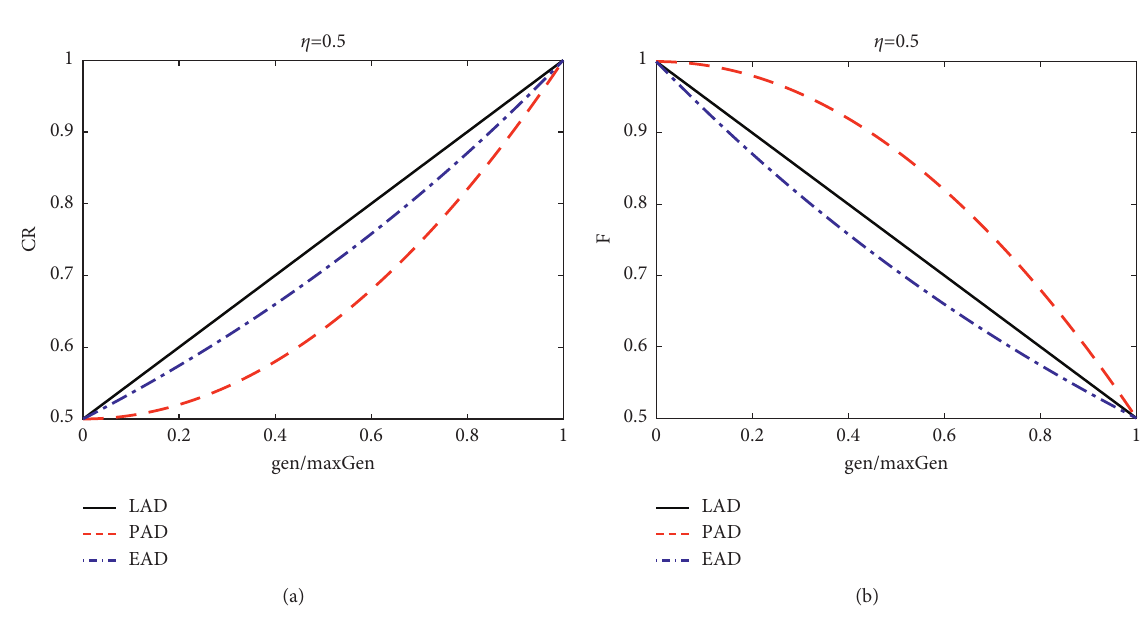
Figure 1: The values of (a) CR and (b)